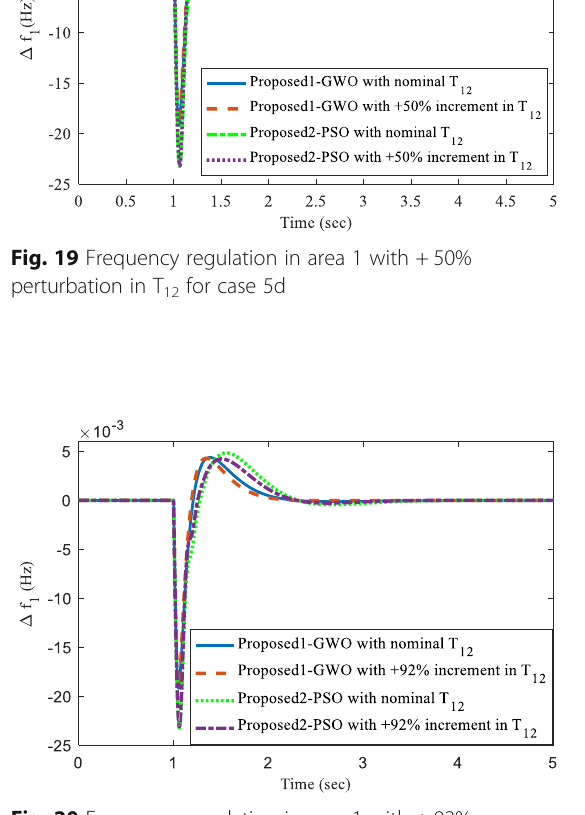
Fig. 23 Frequency deviation in area 2 for case 5e under case study